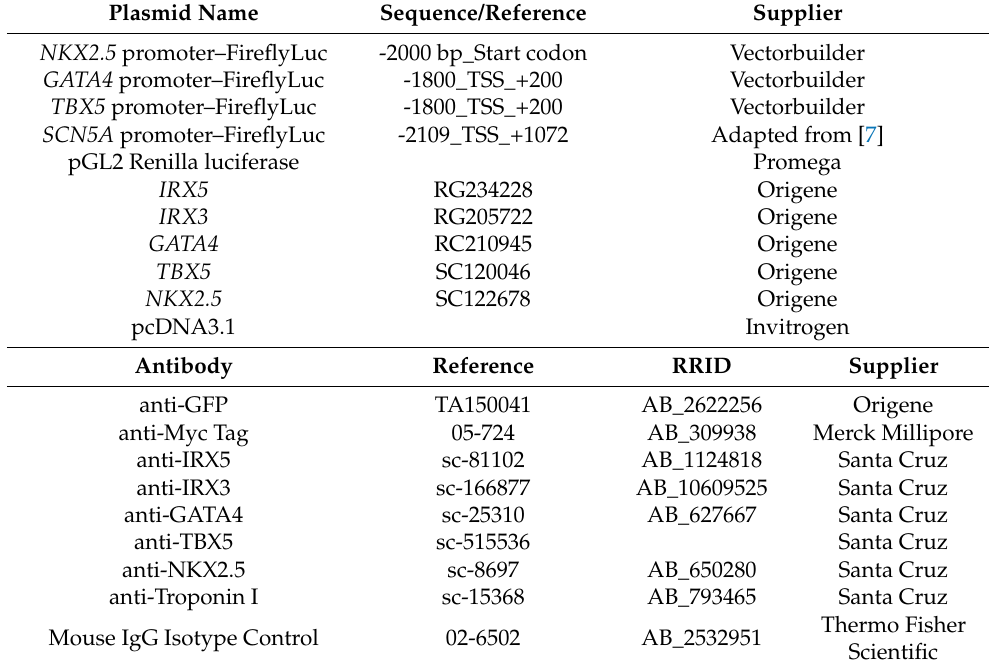
Table 1. Plasmids and antibodies